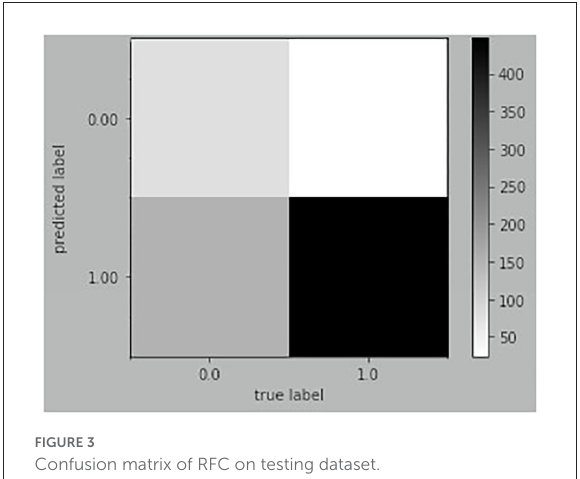
FIGURE3 Confusion matrix of RFC on testing